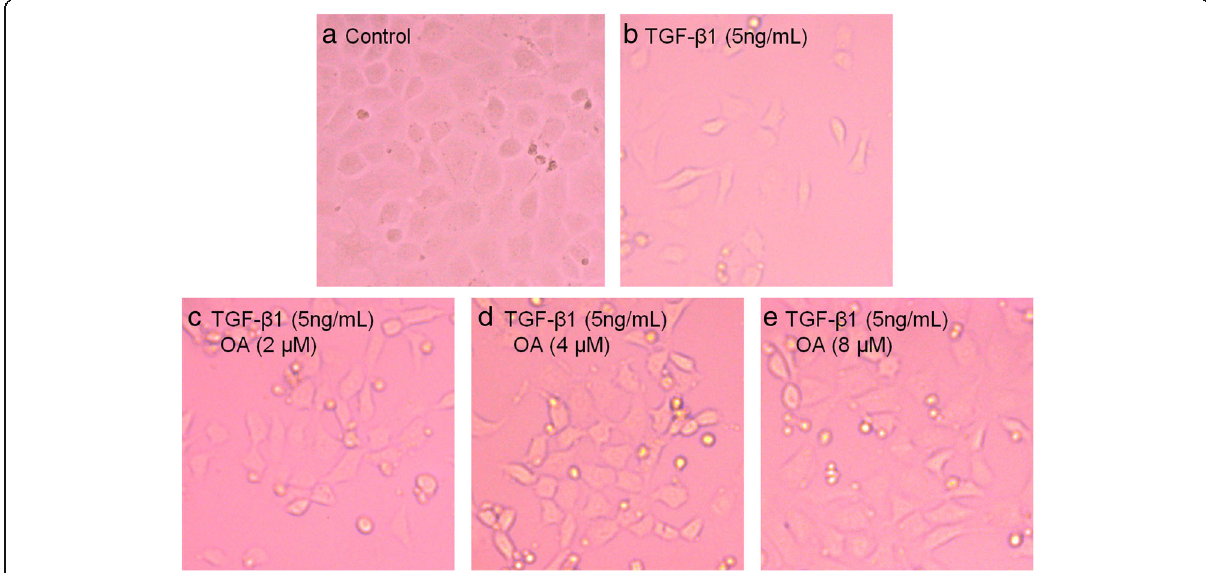
Fig. 2 Effects of OA on TGF- β 1-induced Morphological changes in NRK-52E cells. The cells were incubated with 5 ng/mL of TGF- β 1 for 48 h with different concentrations of OA (0, 2, 4, 8 μ M). a Untreated NRK-52E cells showed a pebble-like shape is clearly observed. b TGF- β 1-treated